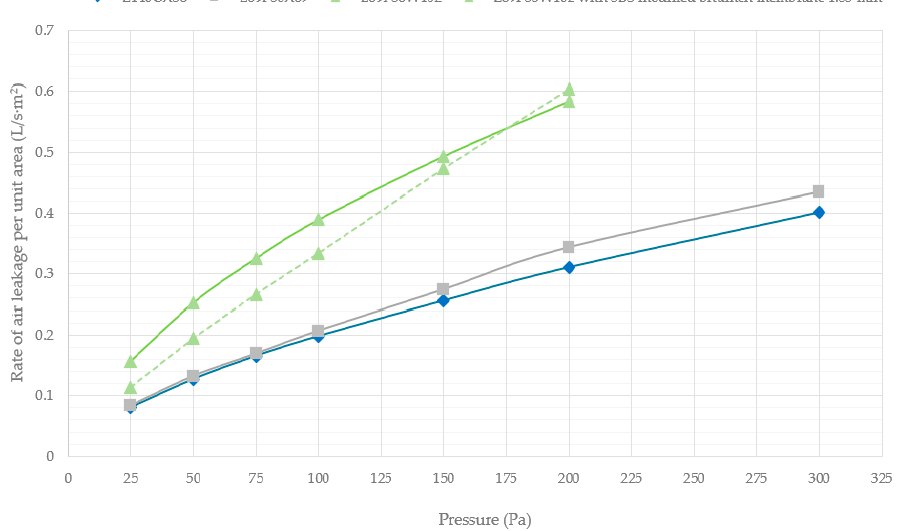
Figure 6. The air leakage that was measured through the A140OX38, A89F38X89 and A89F38W102 assemblies and the A89F38W102 assembly, which was fitted with a modified bitumen SBS mem- brane.